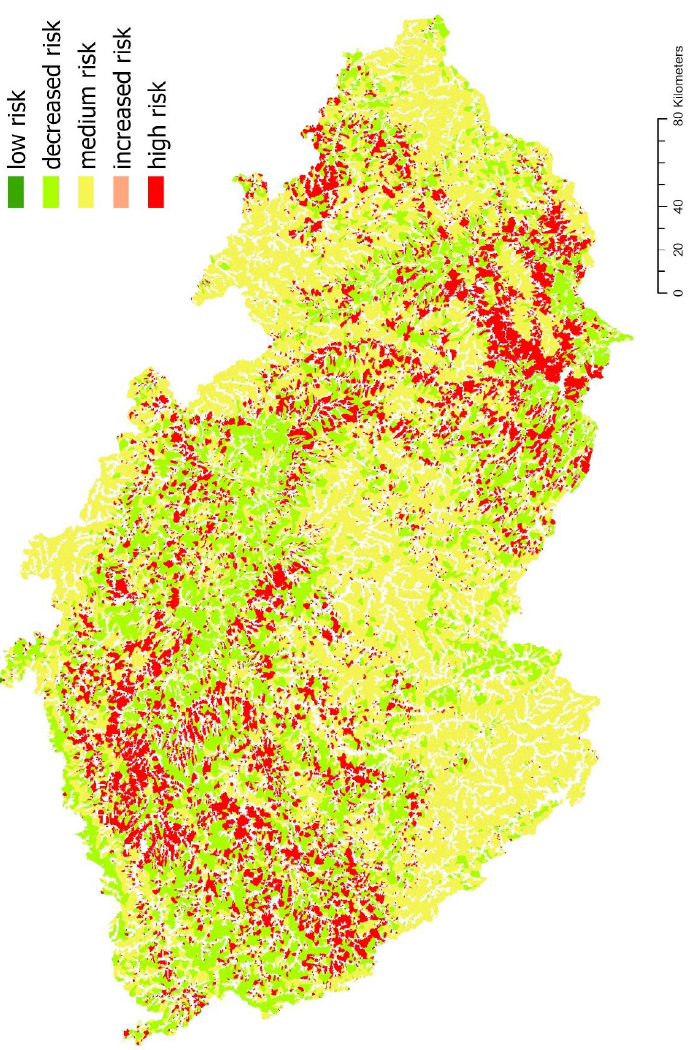
Figure 10. Degree of risk of the Small Headwater Catchments for case of six clusters — optimal count.